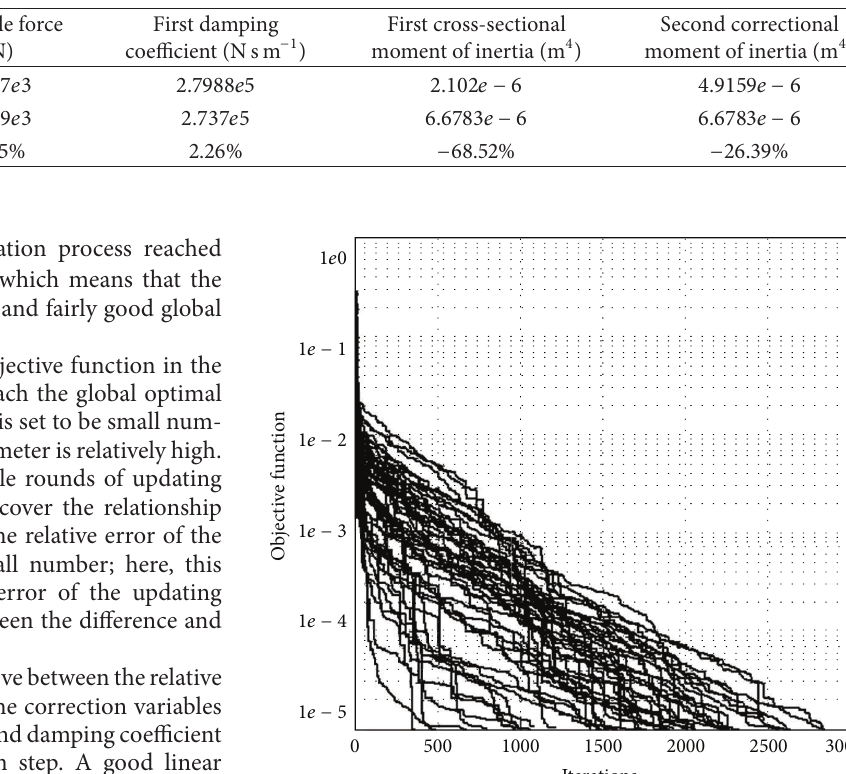
Table 8: Identification results.